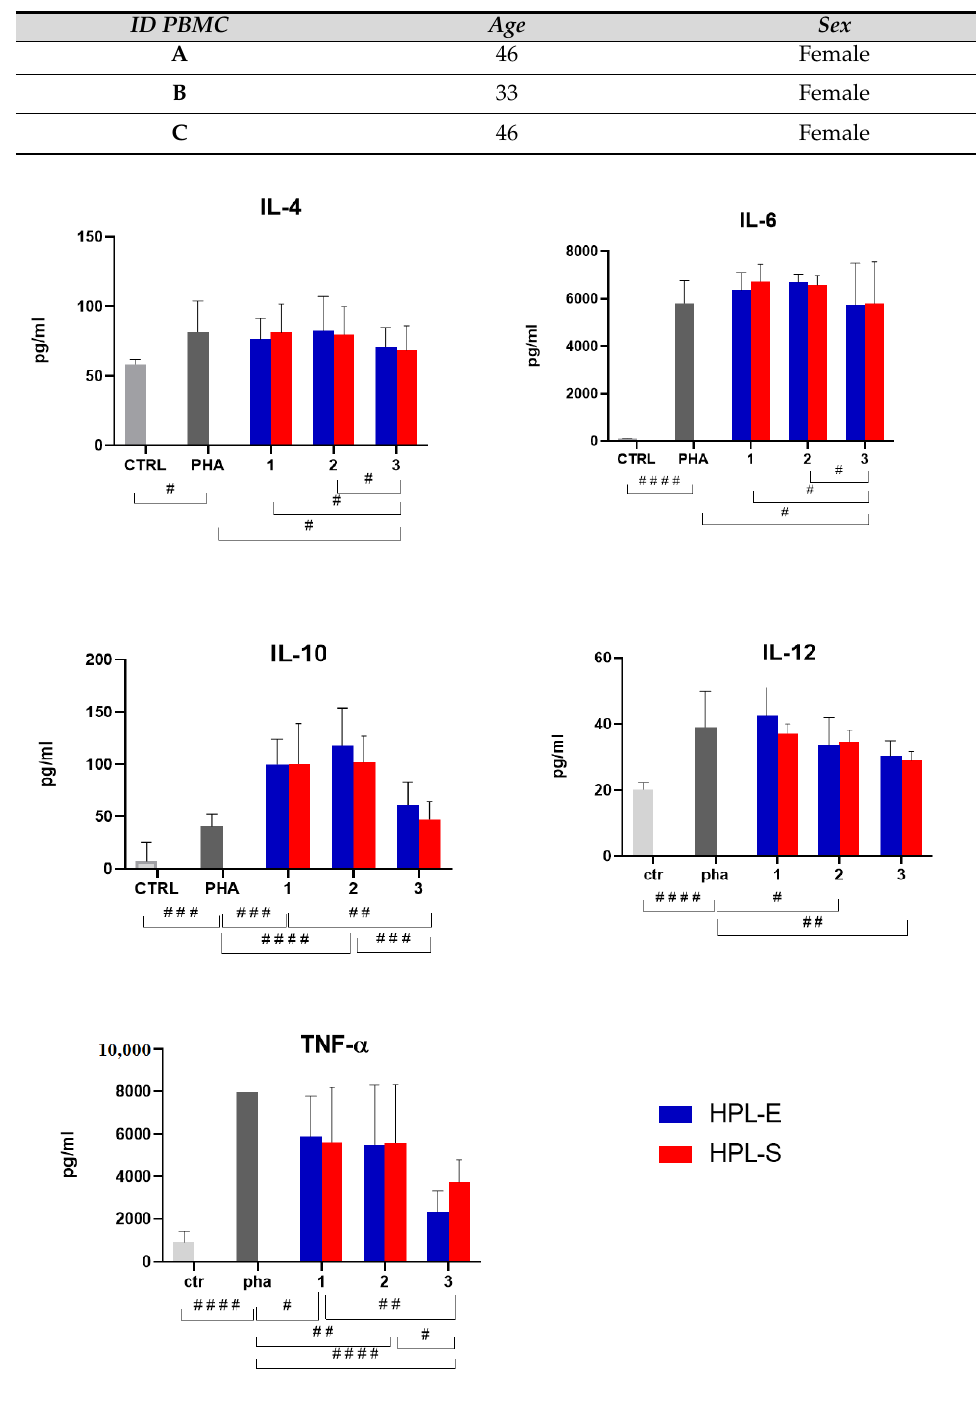
Table 3. PBMC samples enrolled with relative age and sex for secretome biological study.